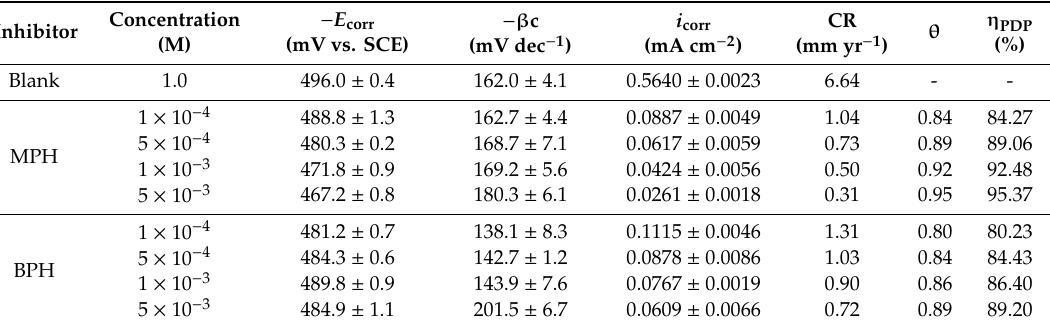
Figure 3. Potentiodynamic polarization curves of MS in hydrochloric acid solution in the presence and absence of various concentrations of BPH ( a ) and MPH ( b ) at 303 K. Table 6. Electrochemical parameter values estimated according to potentiodynamic polarization curves of MS in hydrochloric acid solution in the presence and absence of various concentrations of MPH and BPH at 303